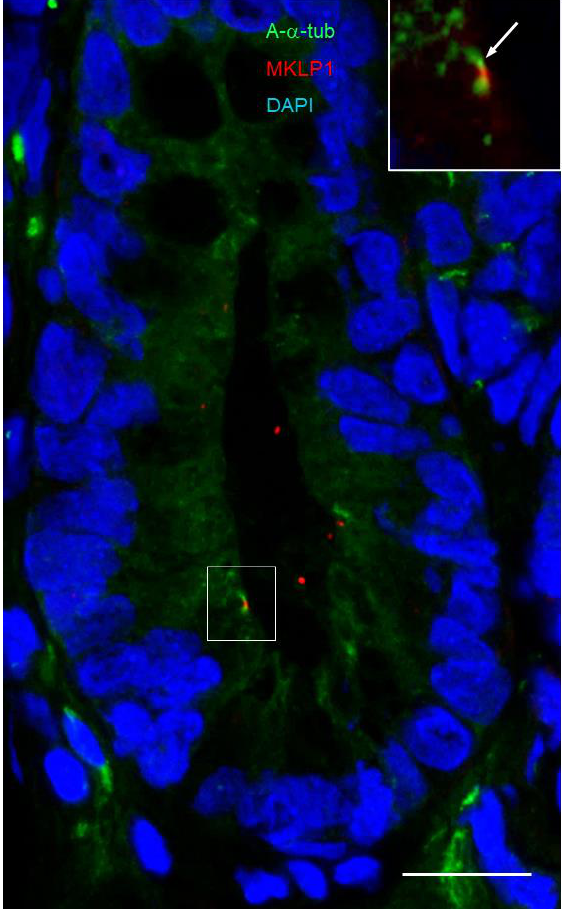
Figure 8. Primary cilia and midbody remnants in the lower third of the crypts of the human small intestine. Representative immunodetection of primary cilia using anti-acetylated tubulin antibody (green staining) and midbody remnants using an anti-MKLP1 antibody (red staining) in the lower portion of a crypt. The 90413h antibody stained one predominant structure that was localized adjacent to a positive MKLP1-labeled dot. Insert in the upper right corner, higher magnification of the section delimited by the square showing the co-staining. Nuclei were stained with DAPI (blue staining). Scale bar is equal to 10 µm.